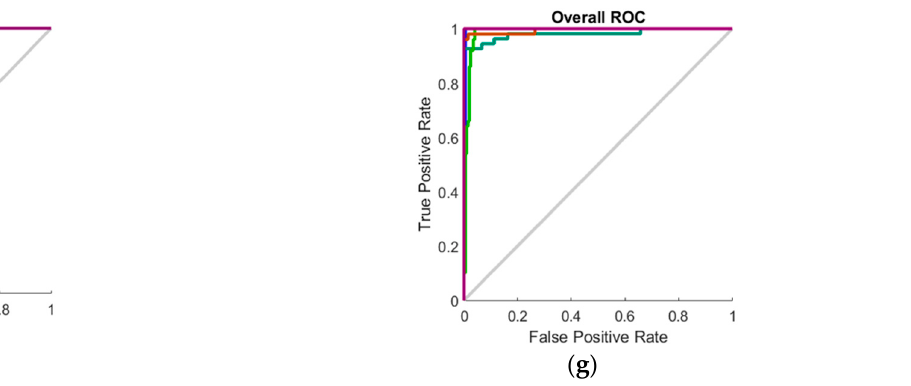
Figure 7. Overall receiver operating characteristic plot for the pattern recognition models of the glasshouse pathogenicity bioassay (models 5–9, a – e , respectively) and the parallel soil experiment (models 10 and 11, f and g ,